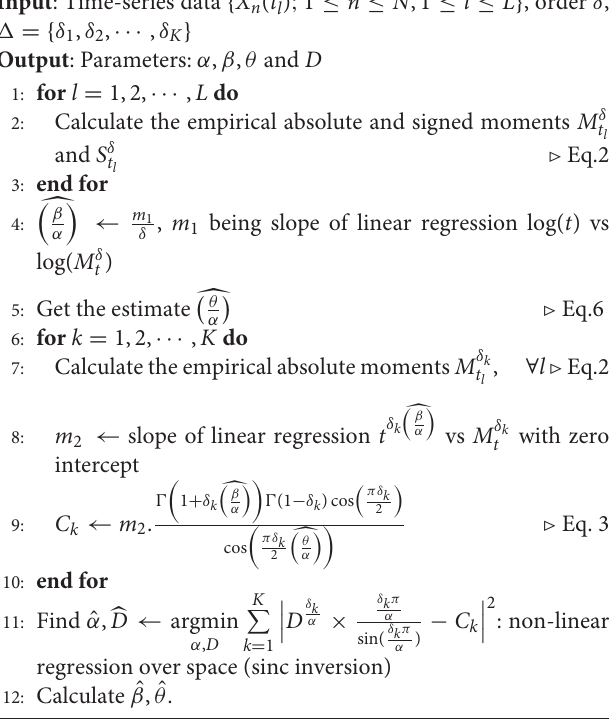
Algorithm 2: | Space-Time Fractional Diffusion: Parameters